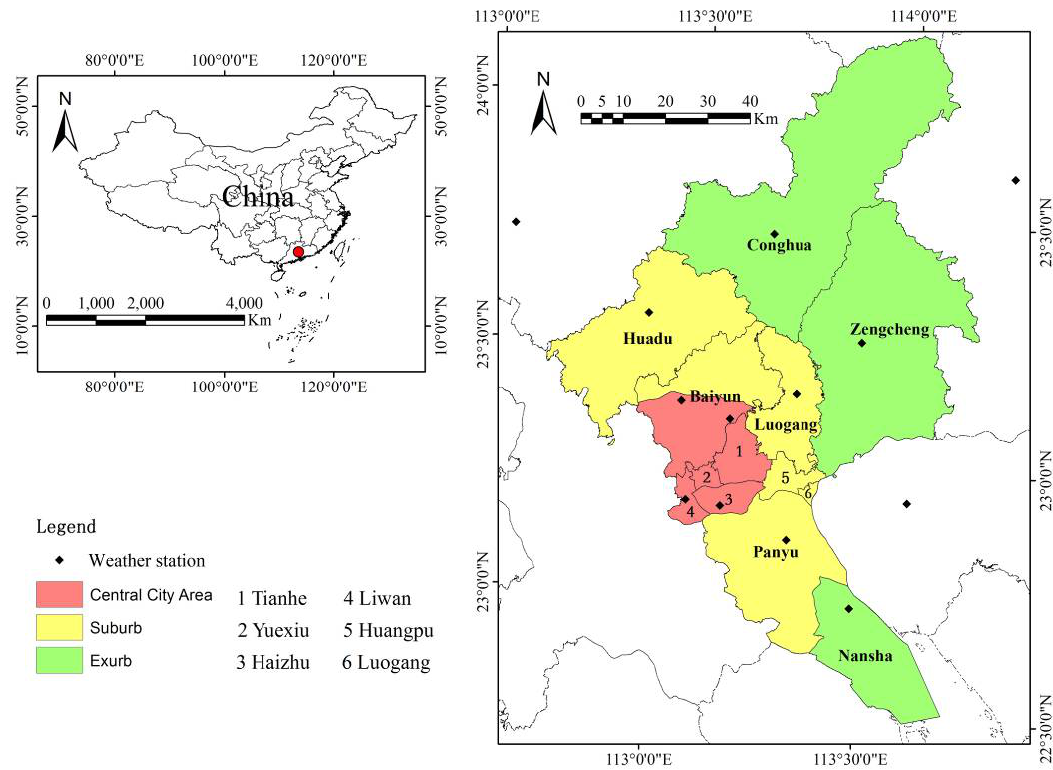
Figure 1. Location of the study